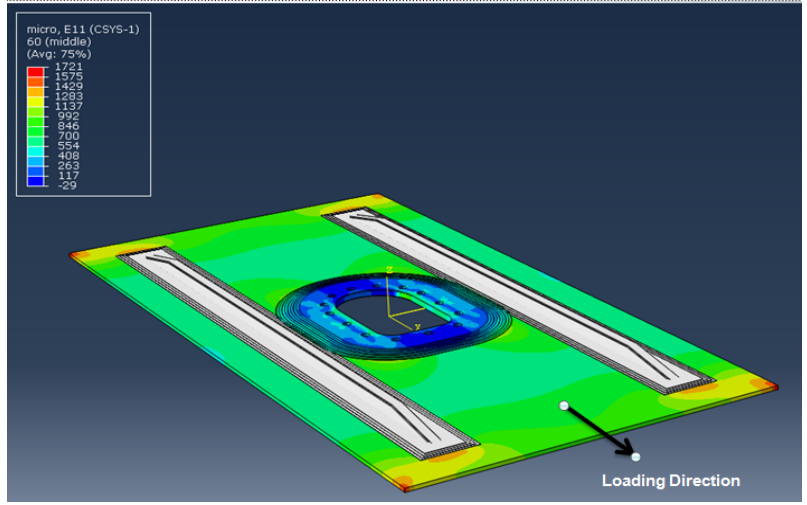
Figure 15. Strain distribution in the panel skin under 9000 kgf load: numerical results from Abaqus (V. 6.13).